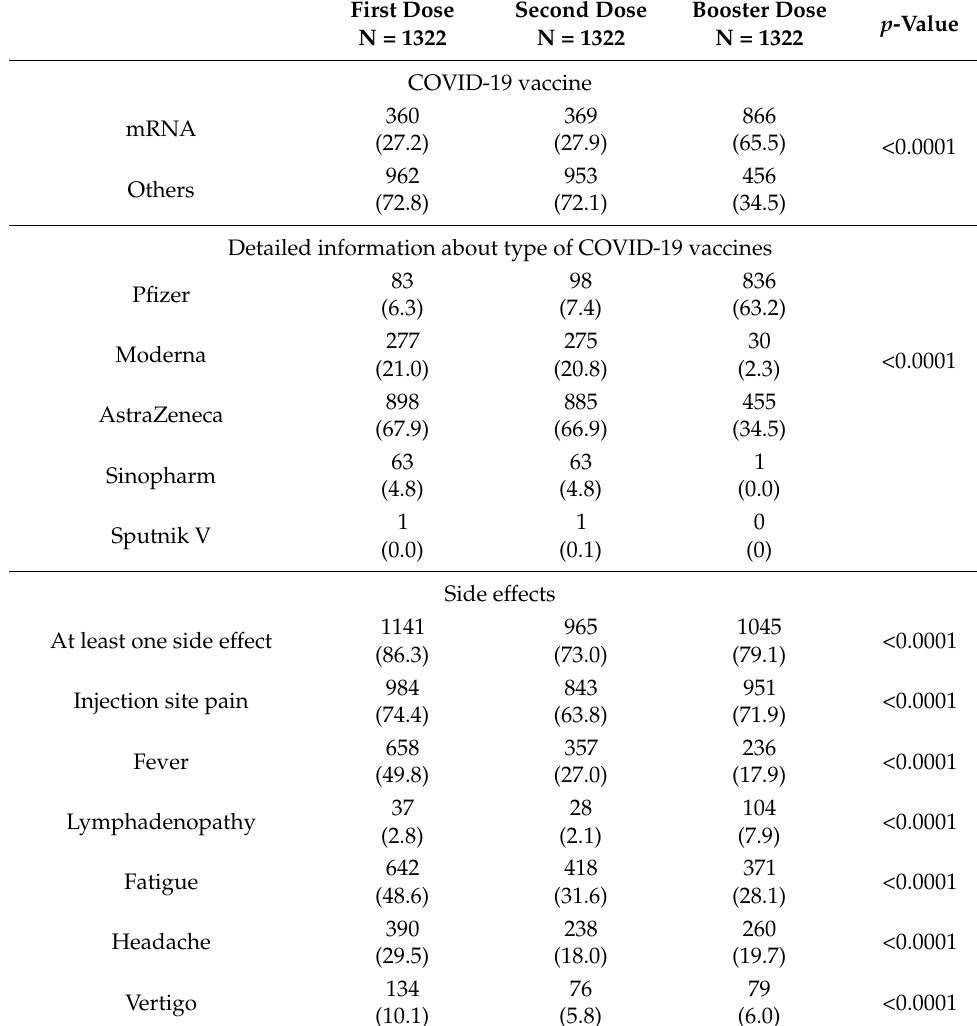
Table 2. COVID-19 vaccines and side effects reported by studied